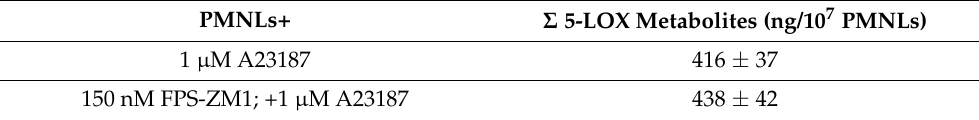
Table 2. Effect of RAGE-specific inhibitor FPS-ZM1 on 5-LOX product formation in PMNLs